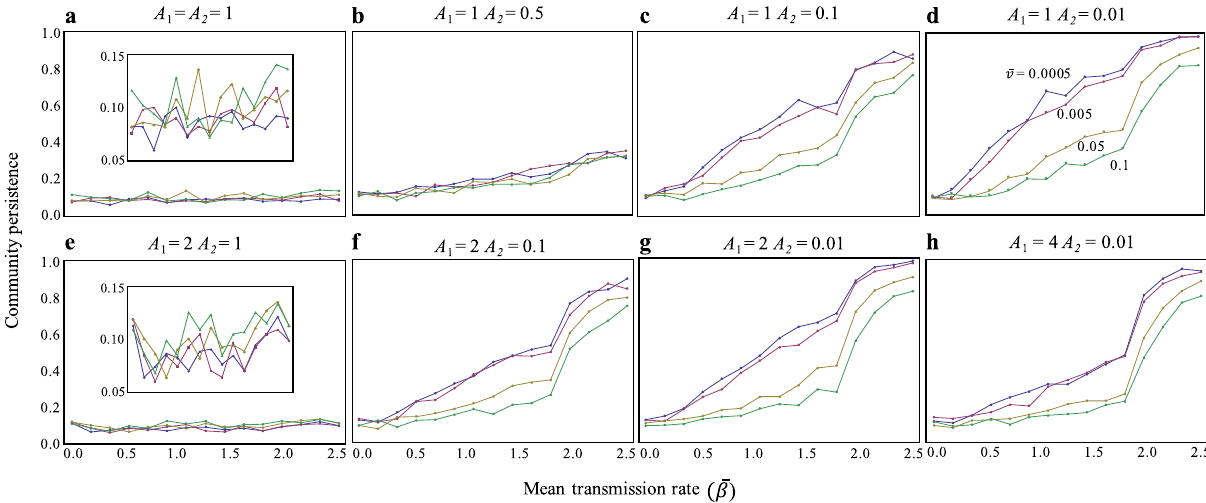
Figure 2. Effects of virulence and infection rate on community stability with varying interaction strengths. Each figure ( a – h ) has different interaction strength values, as indicated in the upper side of each panel. Color represents the mean virulence values. N = 30 and C = 0.3. Parameters are R = 1, r = 1, d = 0.005, a = 0.05, and γ = 0.005.